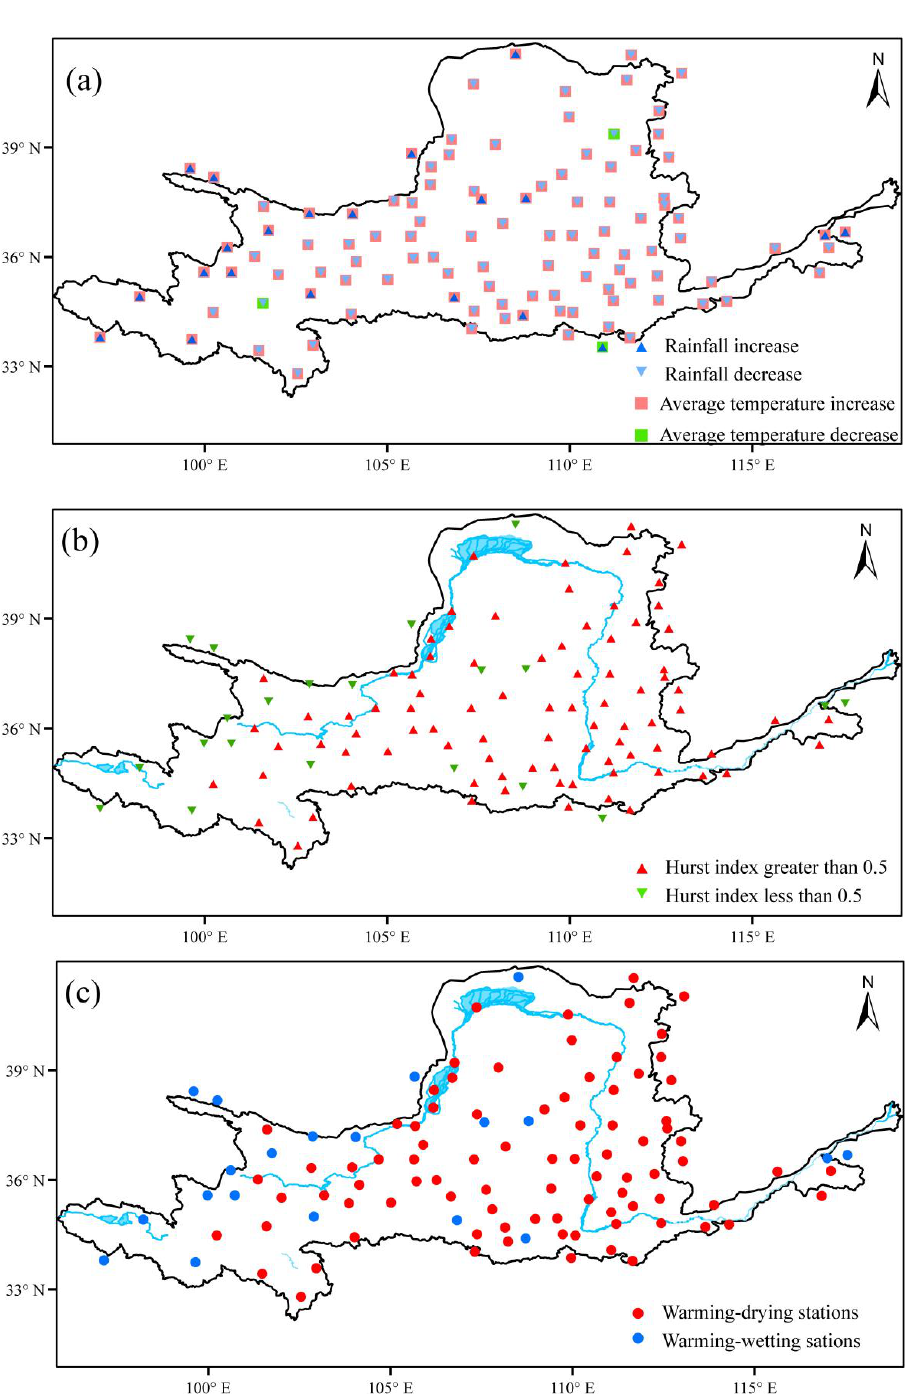
Figure 4. Past variability ( a ); Hurst indices ( b ); and directions of future variability of temperature and precipitation in the Yellow River Basin ( c ).